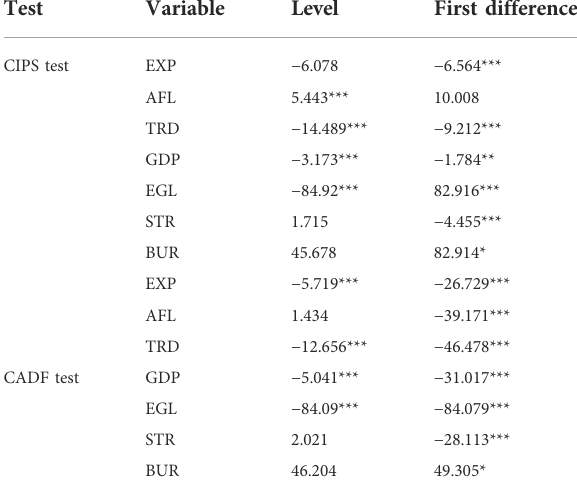
TABLE 3 Panel unit root